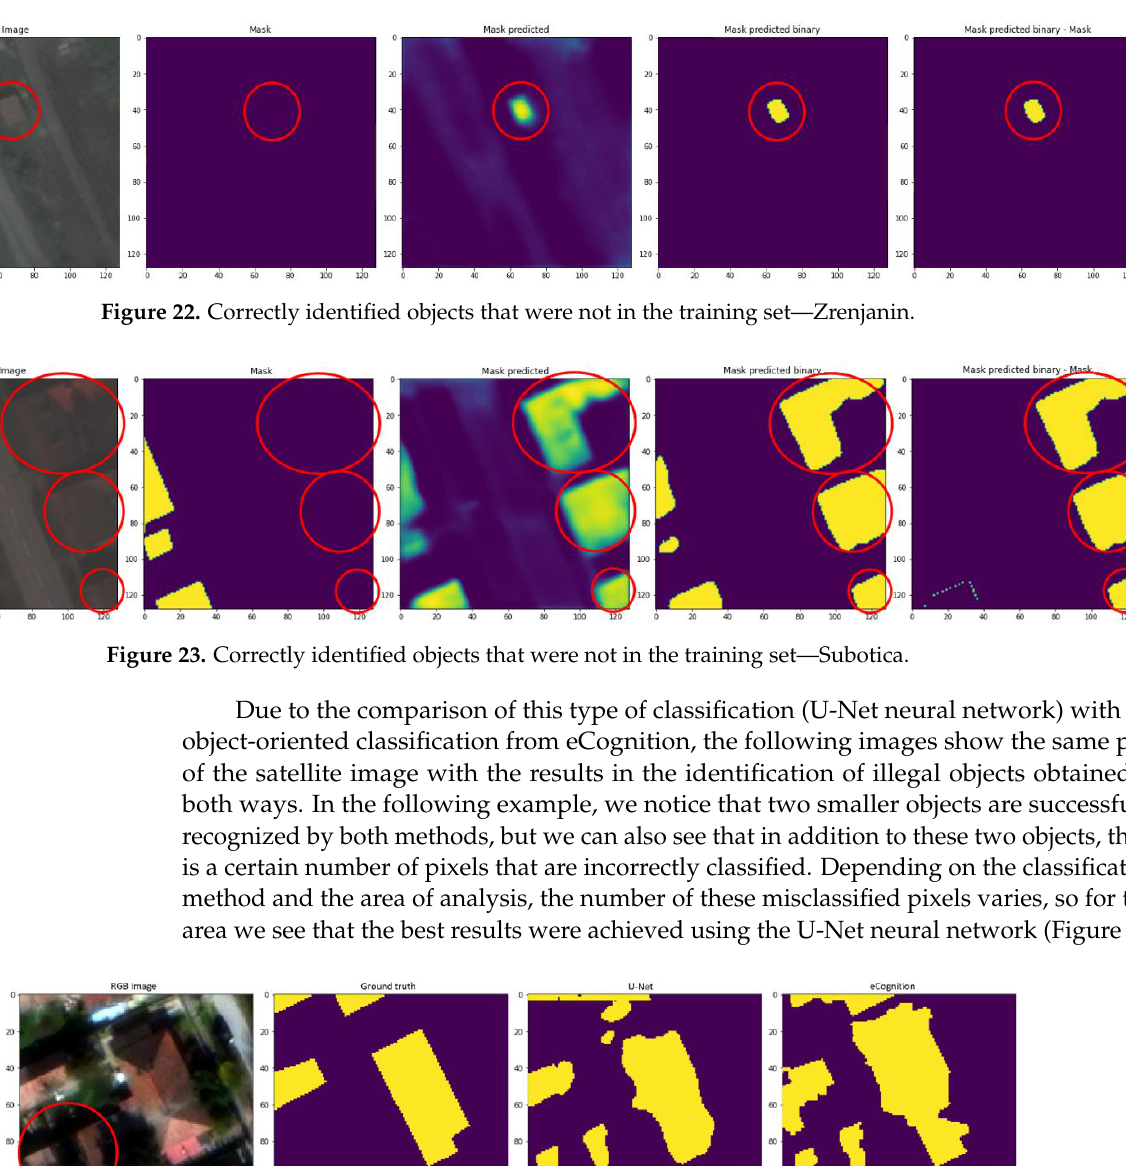
Figure 25. Comparison of the two classification models—misclassified pixels. 3.4.3. Objects Exist in Cadastre and in Orthophoto, but with Different Surfaces A problem that can occur when comparing the data obtained from the cadastre and the data obtained during the identification of buildings is the identification of a slightly wider zone around the building and the assignment to the same class of buildings. The reason for the appearance of this “buffer” is often the acquisition angle, which can make